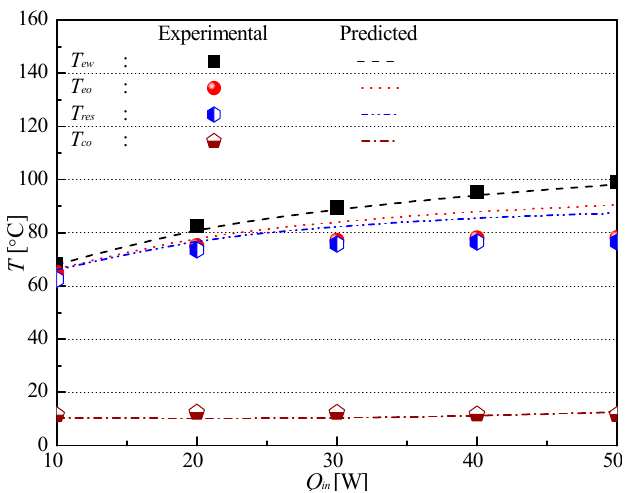
Figure 12. Comparison between experimental and analytical results concerning typical temperatures at the adverse 10° orientation. Figure 13. Comparison between experimental and analytical results concerning vapor temperature in the three orientations.